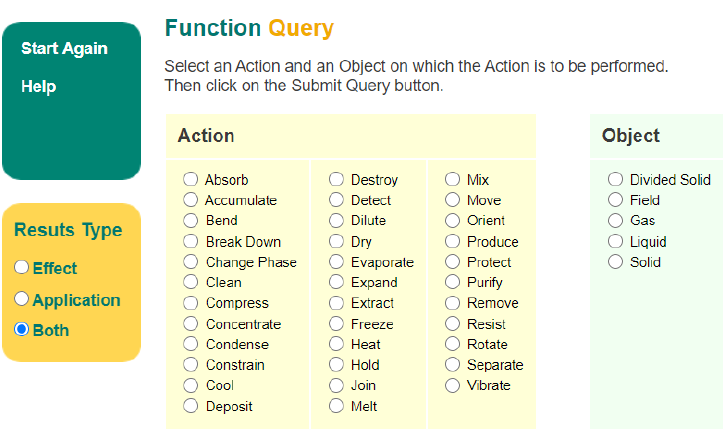
Figure 9. Effect database.